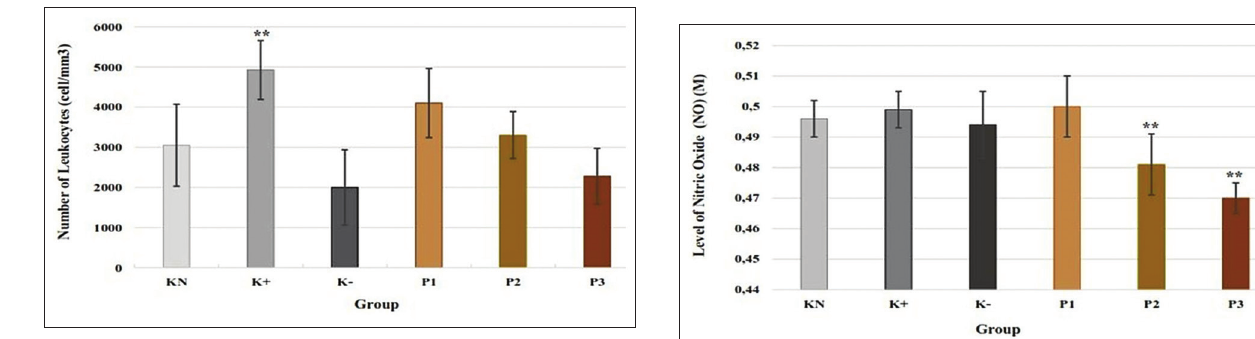
Figure-2: Effect of polysaccharides from Caribena versicolor on a number of leukocytes (cell/mm 3 ). KN=Normal control, K+=Positive control, K−=Negative control, P1=Administration of polysaccharides (PS) before infection, P2=Administration of PS after infection, P3=Administration of PS before and after infection. Values are represented as means±standard deviation (n=6). **p<0.05 compared to KN group.